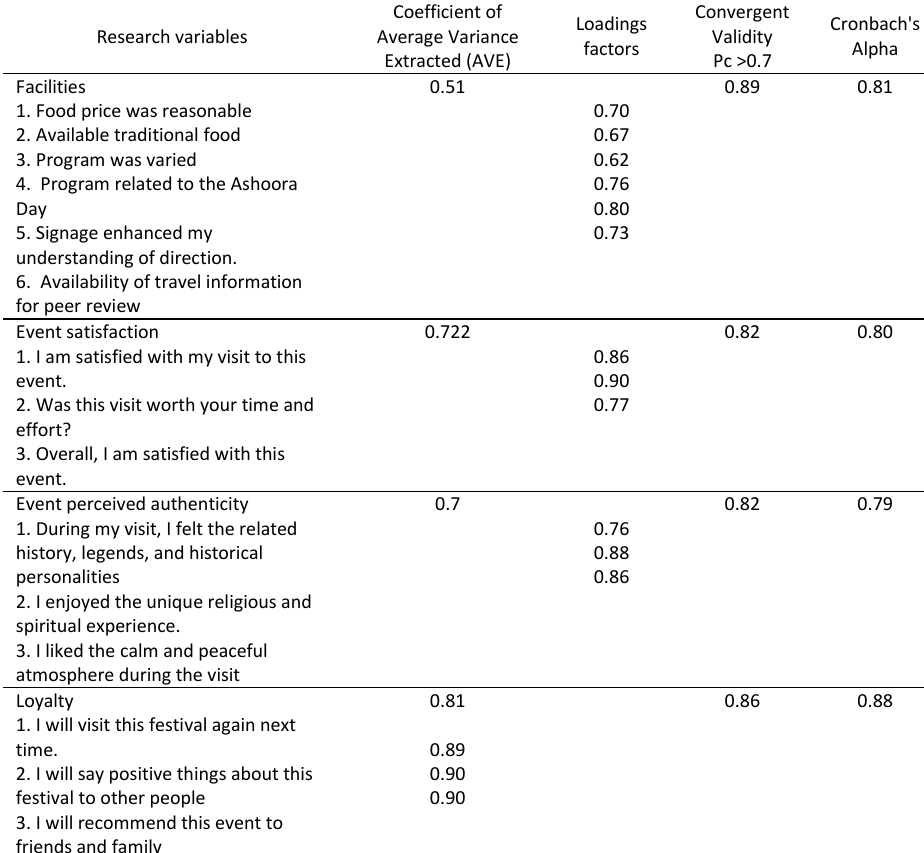
Table 1. Convergent validity and reliability of measurement tools Table 1: Convergent validity and reliability of measurement tools